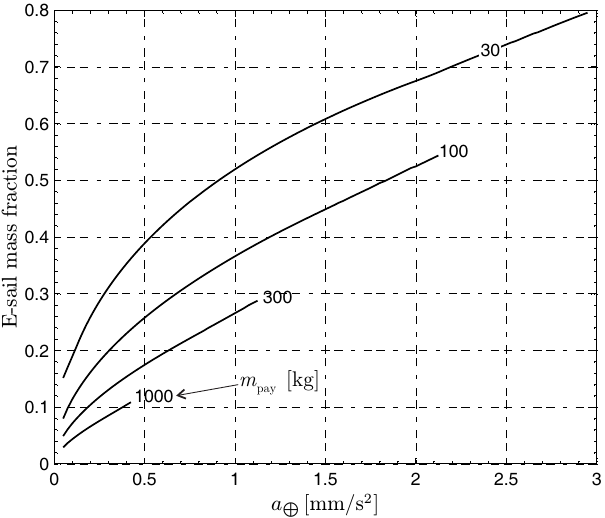
Fig. 4. E-sail mass fraction as a function of a ⊕ and m pay .